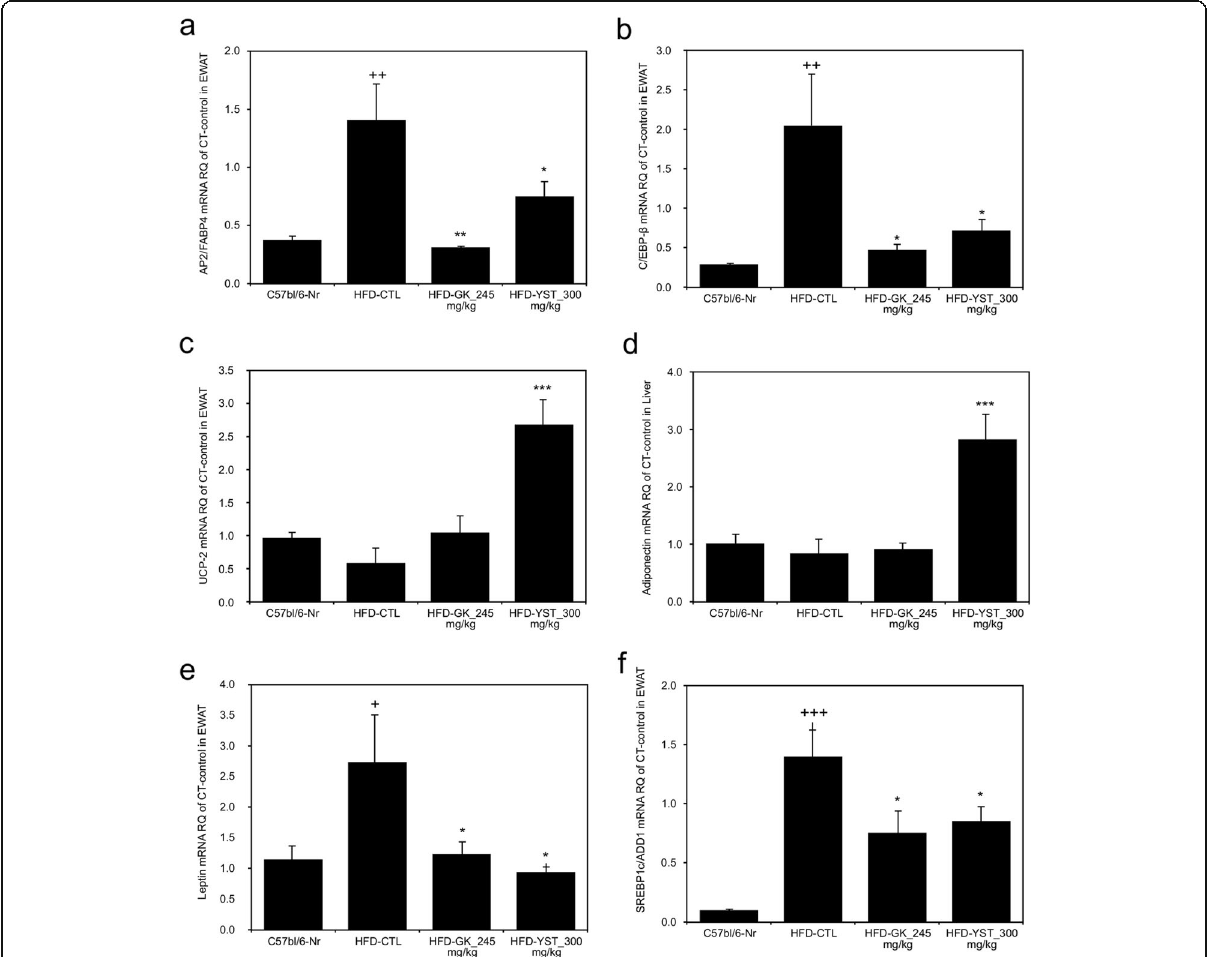
Fig. 4 Effects of YST extract on the mRNA expression in epididymal adipose tissue. a AP2/FABP4 , b C/EBP- β , c UCP-2 , d adiponectin, e leptin, and f SREBP1c/ADD1 . Normal diet group: C57bl/6 J-Nr; HFD-control group: HFD-CTL; HFD plus 245 mg/kg Garcinia cambogia extract: HFD-GK; HFD plus 300 mg/kg YST: HFD-YST. The results are expressed as mean ± SEM ( n = 6). + p < 0.05, ++ p < 0.01, and +++ p < 0.001 compared with C57bl/6 J-Nr, and * p < 0.05, ** p < 0.01, and *** p < 0.001 compared with